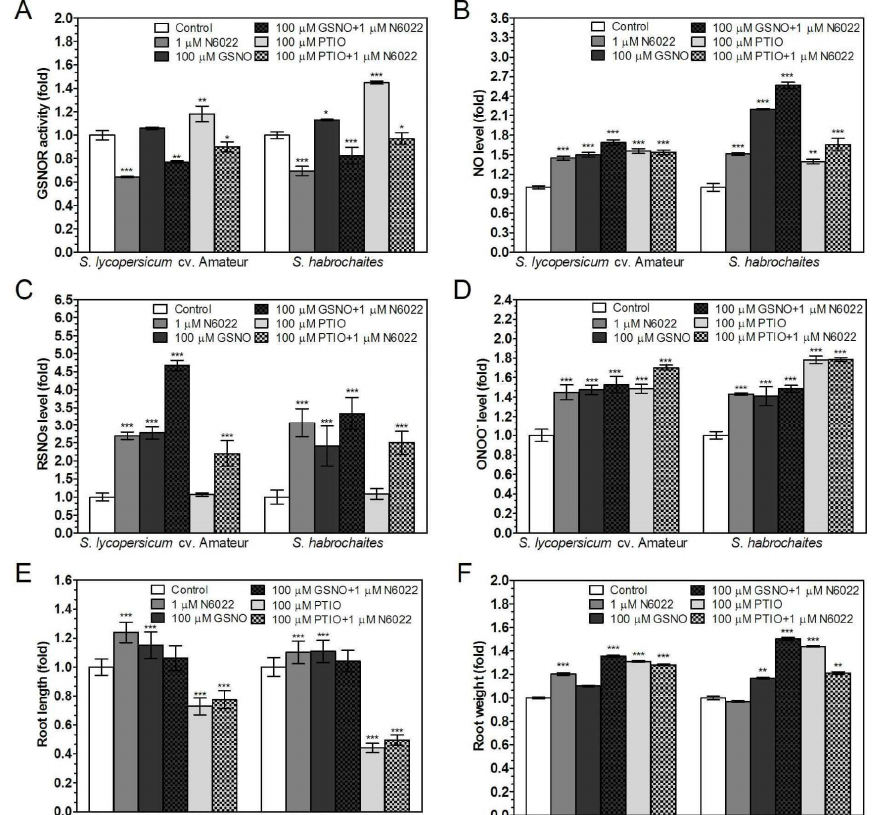
Figure 2. E ff ects of RNS modulators on GSNOR activity, RNS levels and root growth in two Solanum spp. genotypes. Plants were grown in the growth media supplemented with one of selected RNS modulators: 1 µ M N6022 (GSNOR inhibitor), 100 µ M GSNO (S-nitrosation reagent), 100 µ M PTIO (NO scavenger). ( A ) GSNOR activity was evaluated spectrophotometrically at 25 ◦ C by monitoring the decrease of NADH absorbance at 340 nm. ( B ) Changes of NO levels in the root apical parts were monitored by confocal microscopy using 20 µ M DAF-FM-DA. ( C ) The S-nitrosothiol content was determined by the modified Saville method. ( D ) Changes of ONOO − levels in the root apical parts were monitored by microscopy using 20 µ M APF. E ff ects of RNS modulators on physiological parameters were determined as ( E ) root lengths and ( F ) root fresh weights. The data are presented as means ± SD (A–D: n ≥ 3; E–F: n = 30) relative to the value of tested parameters measured for control plants grown in media without ROS modulators. Significantly di ff erent means from control values are denoted by asterisks (ANOVA, * p < 0.05, ** p < 0.01, *** p < 0.001).